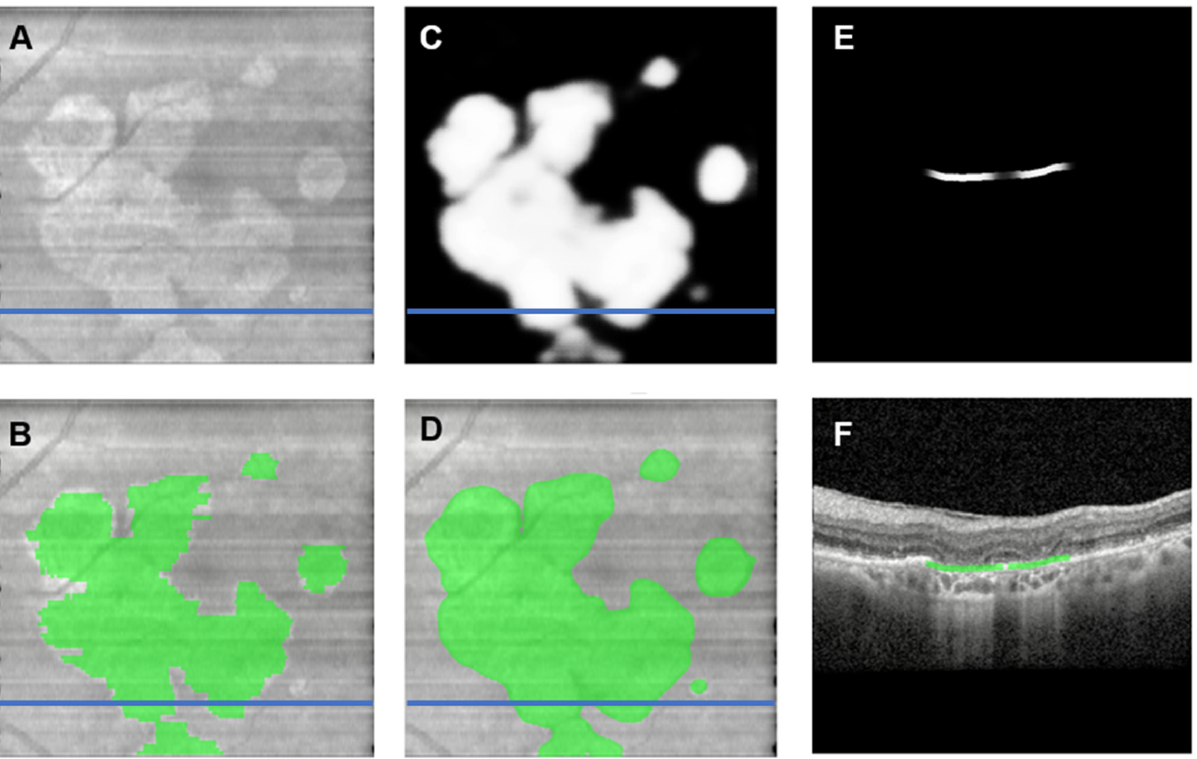
Figure 6 . ( A , B ) Model training input images; ( C ) Grayscale output from the en face ML-model; ( D ) Binary output mask from the en face ML-model demonstrating excellenct concordance to the ground truth masks ( B ) with some additional identified areas of hypertransmission defects; ( E , F ) Projection of the en face model prediction onto the OCT B-scan BM line for GA area prediction. The blue line indicates the position of the B-scan. ML: Machine learning; OCT: Optical Coherence Tomography. Captured using Spectralis HRA+OCT (Heidelberg Engineering, Heidelberg, Germany) with the 97 B-scan macular cube protocol.